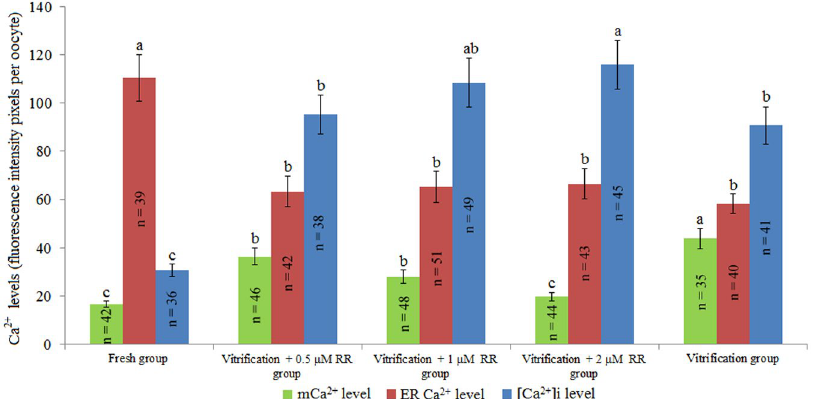
Figure 3. Effect of RR treatment on Ca 2 + levels in vitrified bovine oocytes. a,b,c Values with different superscripts differ significantly between groups ( P < 0.05).